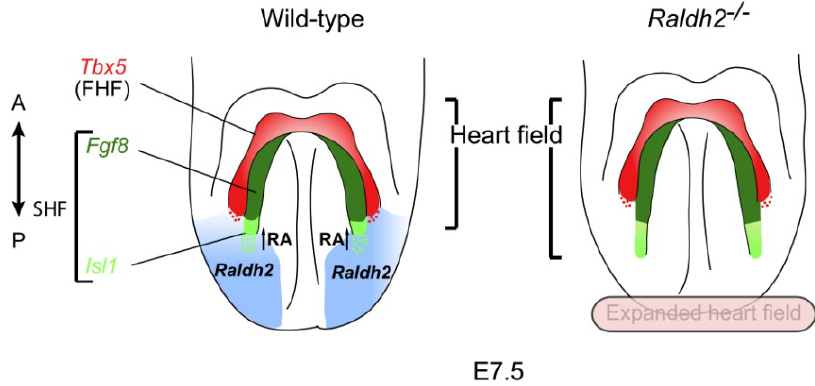
Figure 2. Retinoic acid signaling during early cardiogenesis. Raldh2 , the main enzyme responsible for Retinoic Acid (RA) synthesis during development, is expressed in the posterior lateral mesoderm. Thus, production of RA provides a signal to establish the posterior boundary of the heart field. Tbx5 is expressed in the first heart field (FHF) whereas Fgf8 and Isl1 mark the anterior and posterior domains of the second heart field (SHF). Raldh2 -/- mutant embryos exhibit caudal expansion of Fgf8 and Isl1 expression within the posterior lateral mesoderm. The anterior (A)–posterior (P) axis is